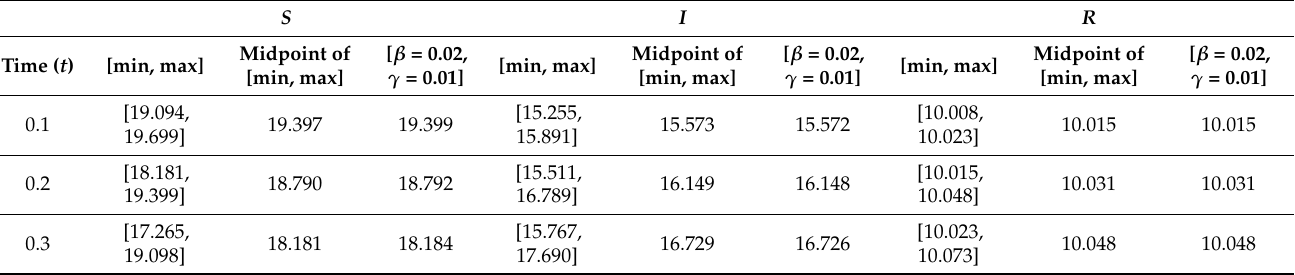
Table A4. The solutions obtained by the homotopy analysis method with intervals (cid:101) β = [ 0.01, 0.03 ] and (cid:101) γ = [ 0.01, 0.015 ]